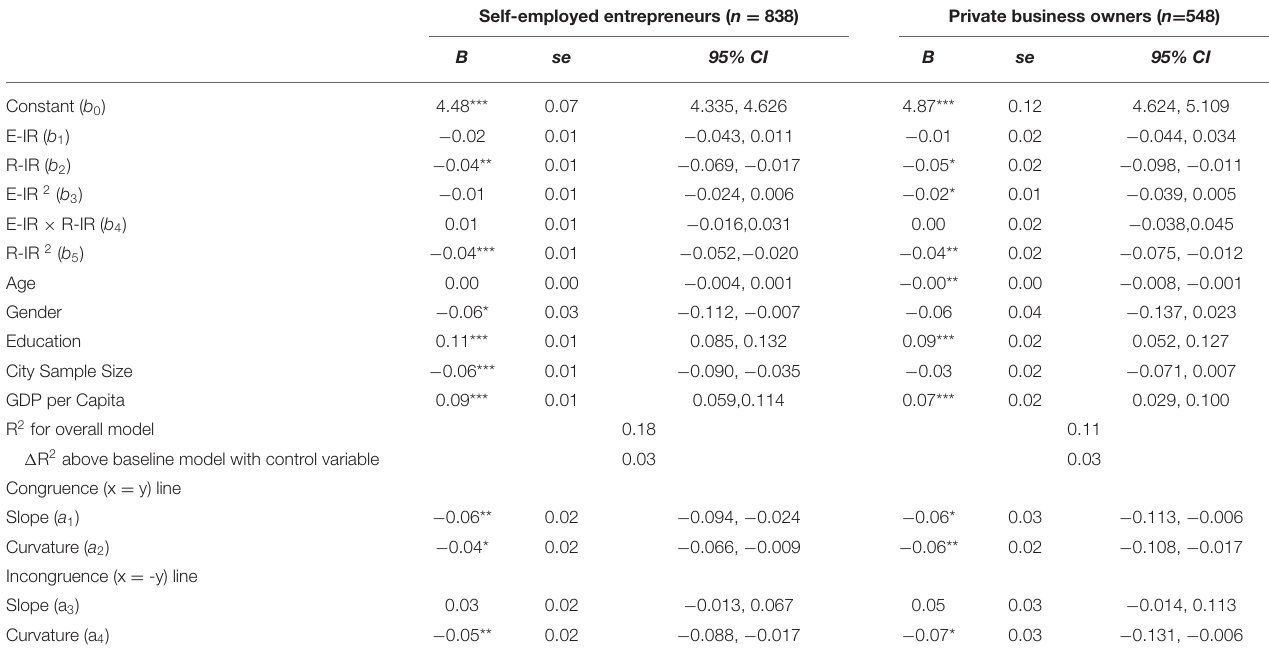
TABLE 2 | Results of the polynomial regressions of entrepreneurial success on the IR of entrepreneurs and regional